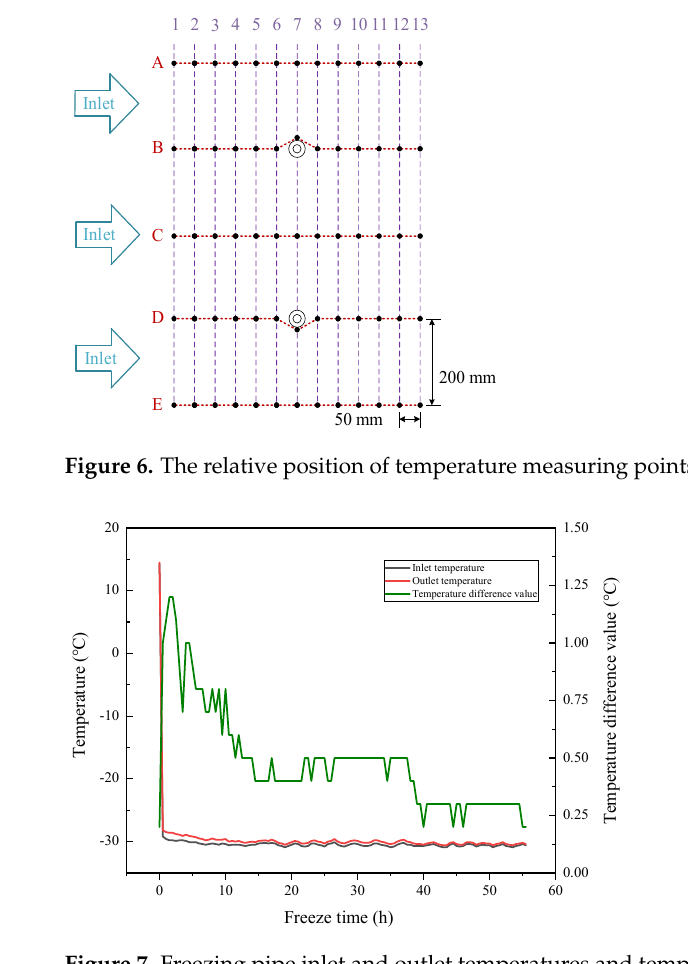
Figure 7. Freezing pipe inlet and outlet temperatures and temperature difference.